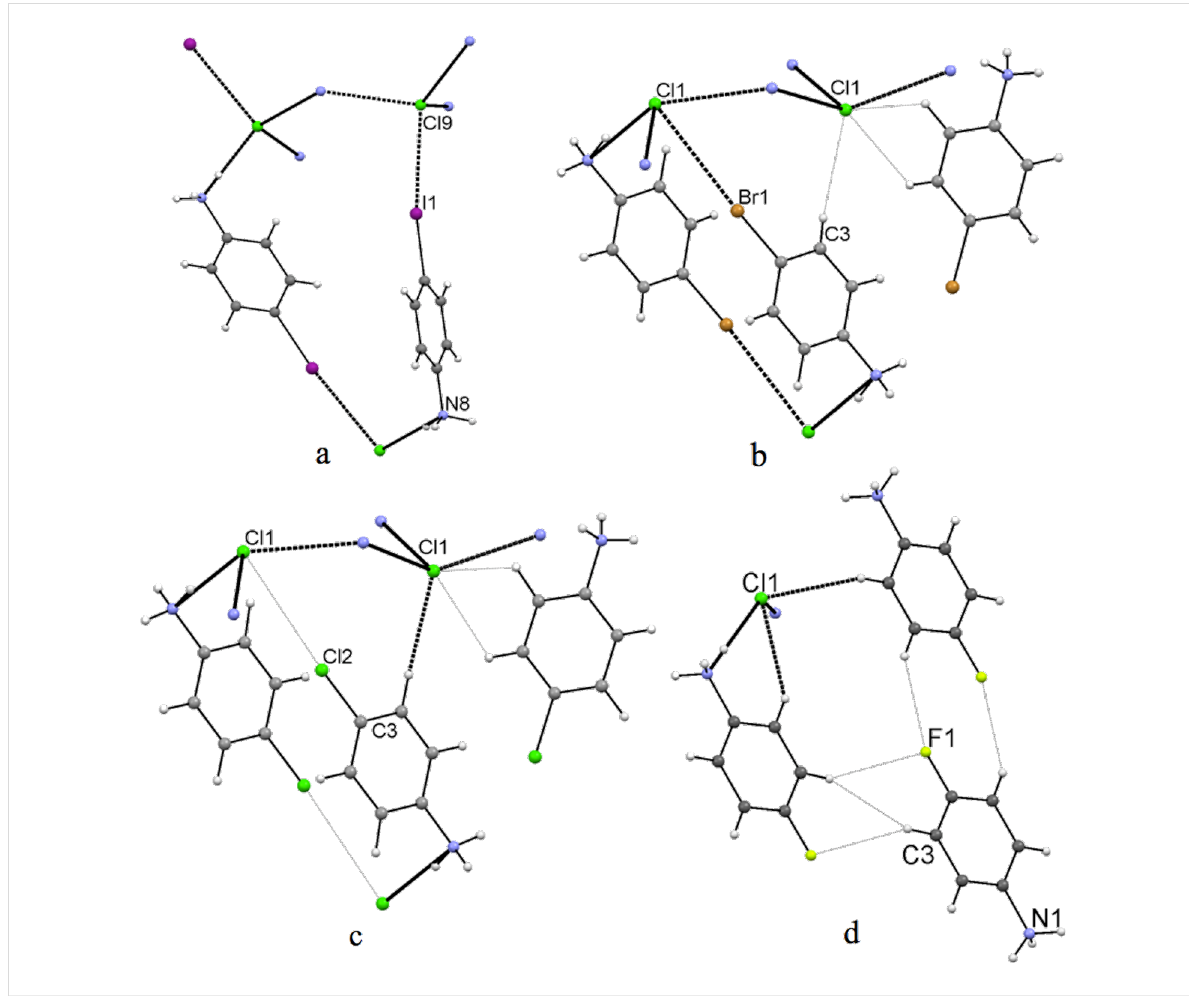
Figure 2: Interaction contacts in 4-IPhNH 3 Cl ( 1 ; a), 4-BrPhNH 3 Cl ( 2 ; b), 4-ClPhNH 3 Cl ( 3 ; c) and 4-FPhNH 3 Cl ( 4 ; d). Dotted lines represent the hydrogen and halogen interactions, where the shorter (stronger) contact distances are shown in bold lines and the longer (weaker) with narrow lines.